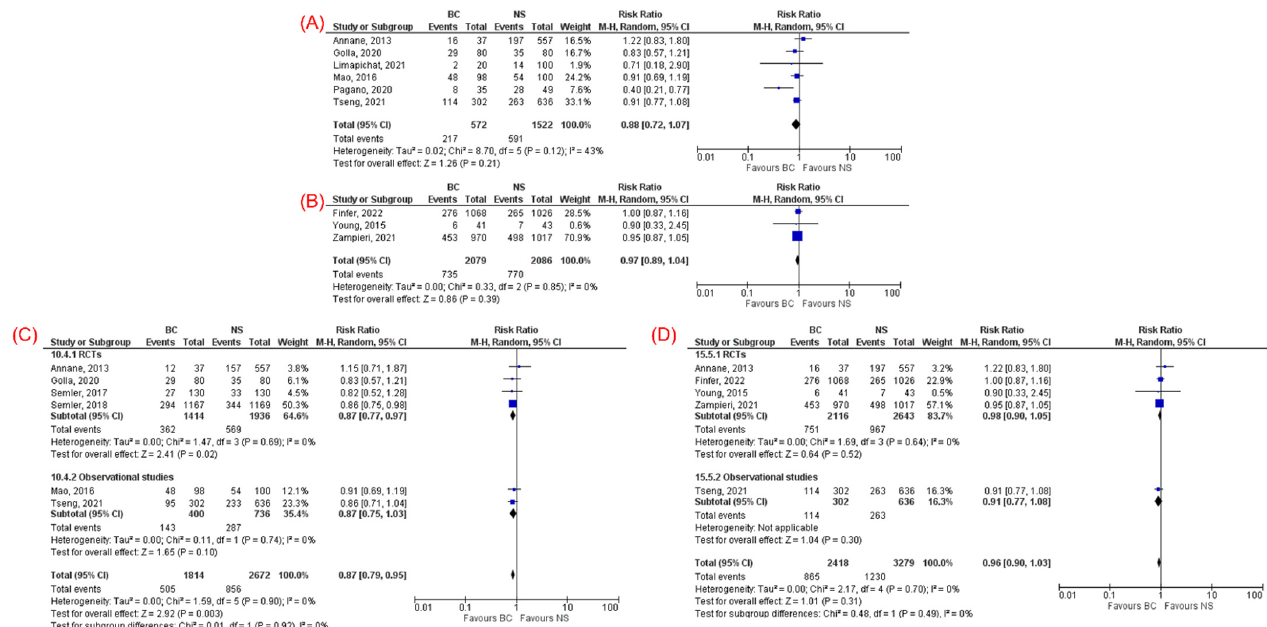
Figure 3. Subgroup analysis based on the type of balanced crystalloids: ( A ) lactated ringer and ( B ) Plasmalyte for overall mortality. Forest plots comparing balanced crystalloids and normal saline regarding: ( C ) 28/30-day mortality and ( D ) 90-day mortality.